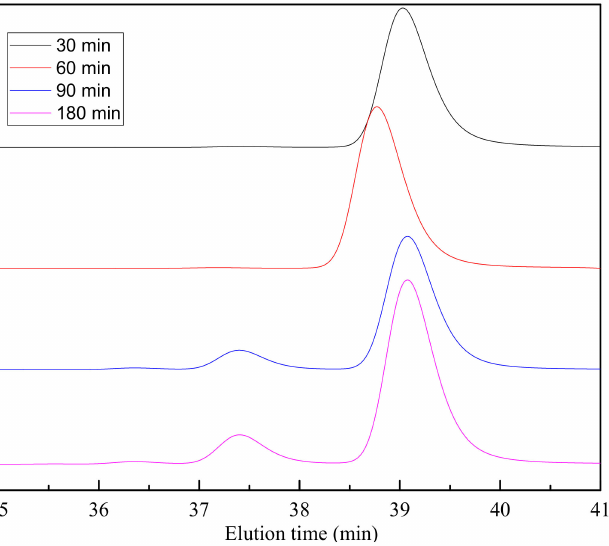
Figure 8. GPC results for the depolymerization at 180 ◦ C for different reaction